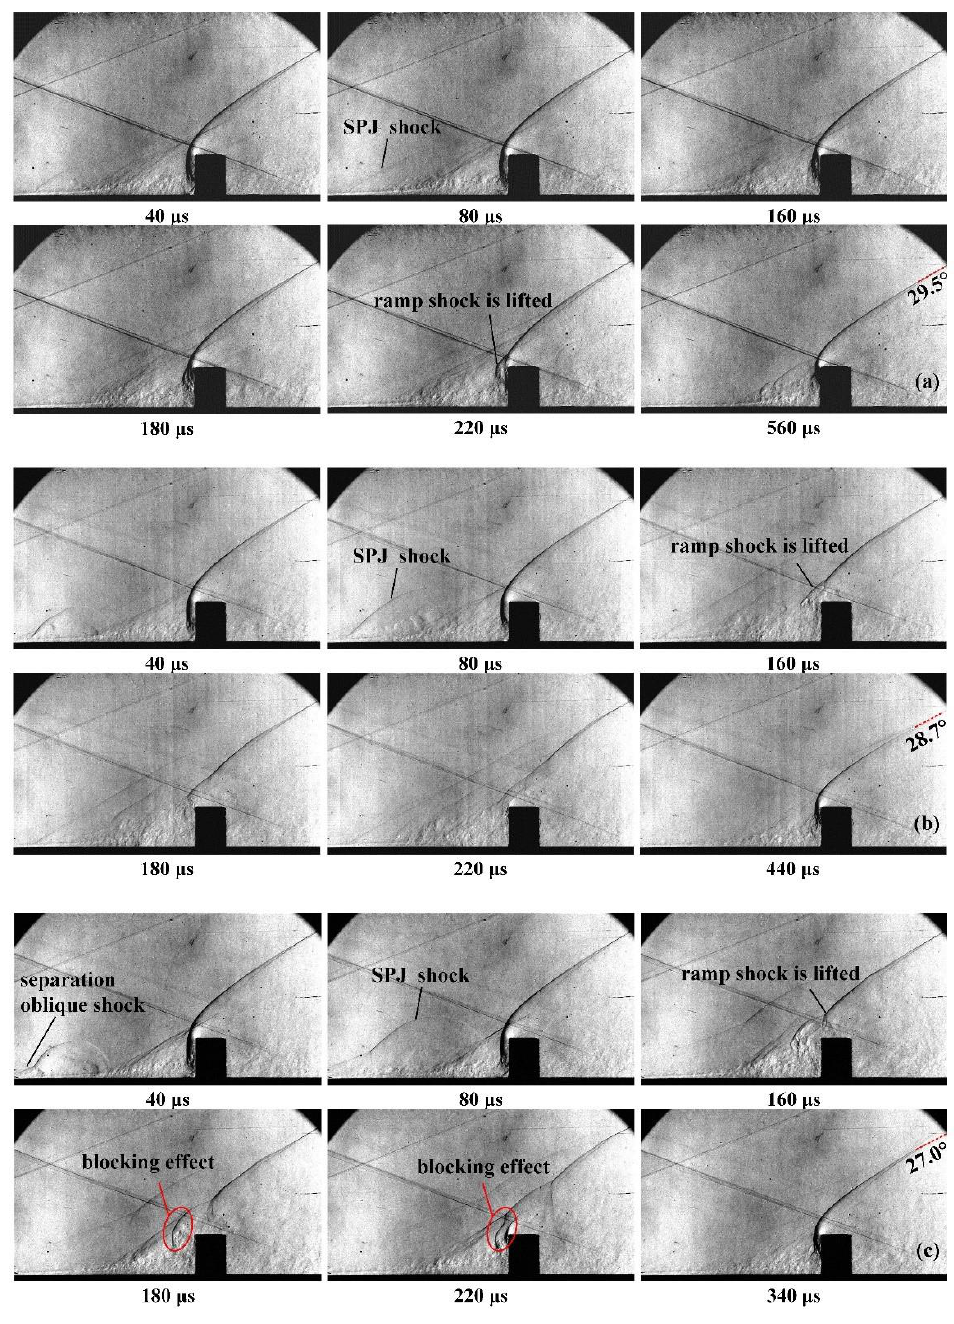
Figure 8. Comparison of the flow field evolution process with different exit diameters: ( a ) case4—1.5 mm, ( b ) case5—5 mm, ( c ) case6—11 mm.